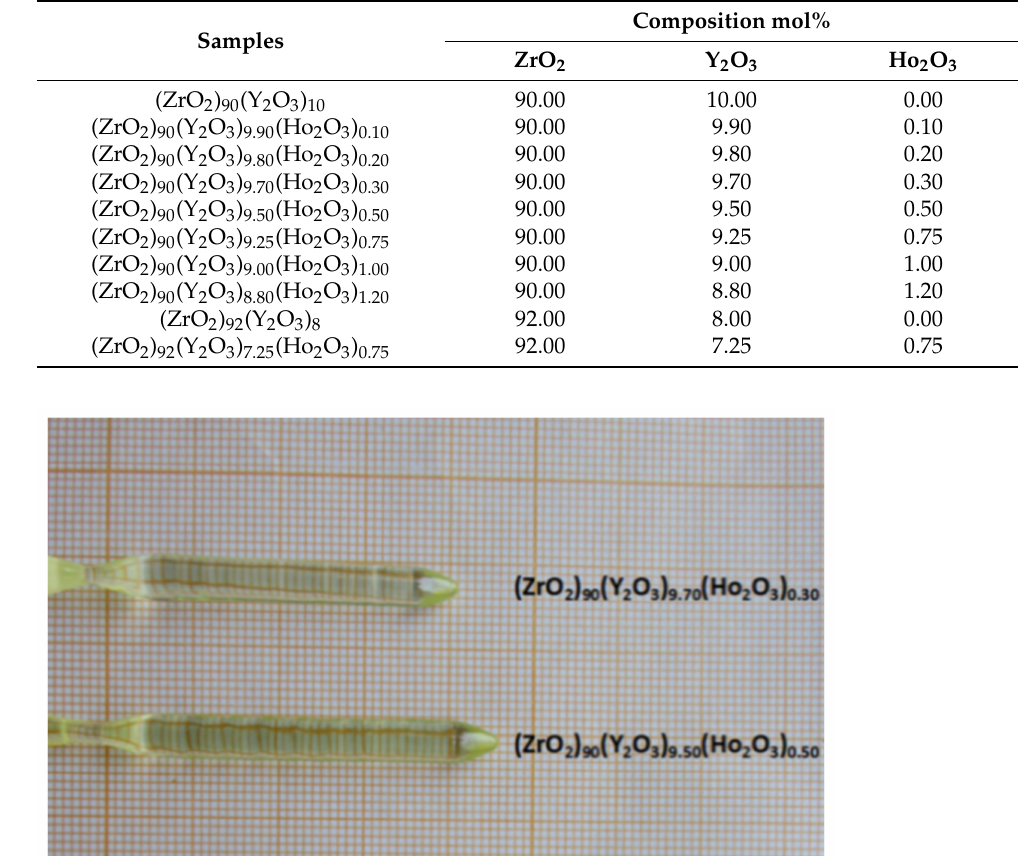
Table 1. Chemical compositions of Ho 2 O 3 -doped YSZ samples.